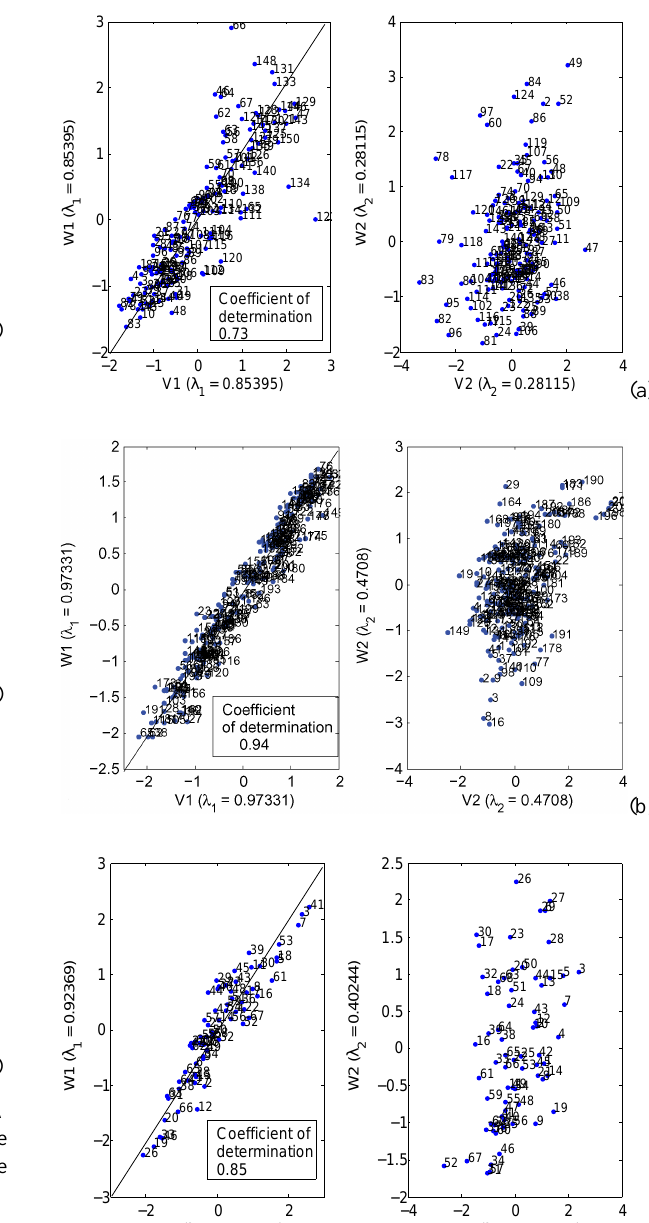
Fig. 4. Scatterplot of sites in the canonical spaces (V1, W1) and (V2, W2) for (a) southern Quebec, (b) Arkansas and (c) Texas. The first column illustrates the canonical (V1, W1) space and the second column illustrates the (V2, W2)